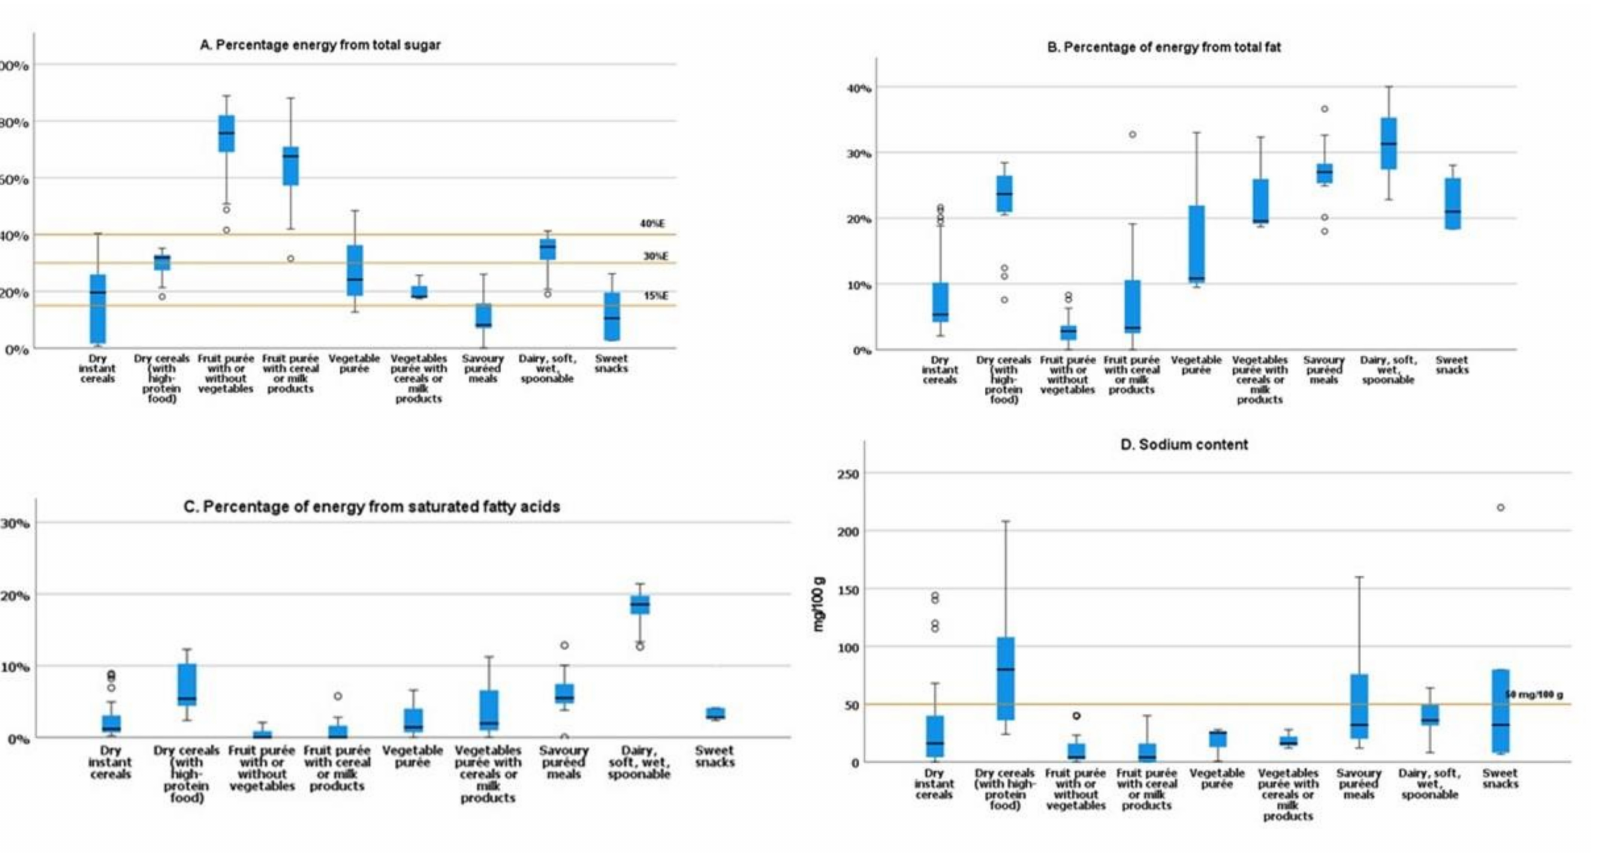
Figure 3. ( A ) Percentage energy from total sugar of food products; the yellow lines at 15%, 30%, and 40% indicate the adopted percentage of calories from total sugar to have a flag on the front-of-pack label by the NPM of the WHO/Europe for several CACFs categories. ( B ) Percentage energy from total fat of food products; ( C ) percentage energy from total saturated fatty acids of food products; ( D ) sodium content (mg/100 g) of food products. The yellow line at 50 mg/100 g indicates the upper limit for sodium adopted by the NPM of the WHO/Europe for some CACFs